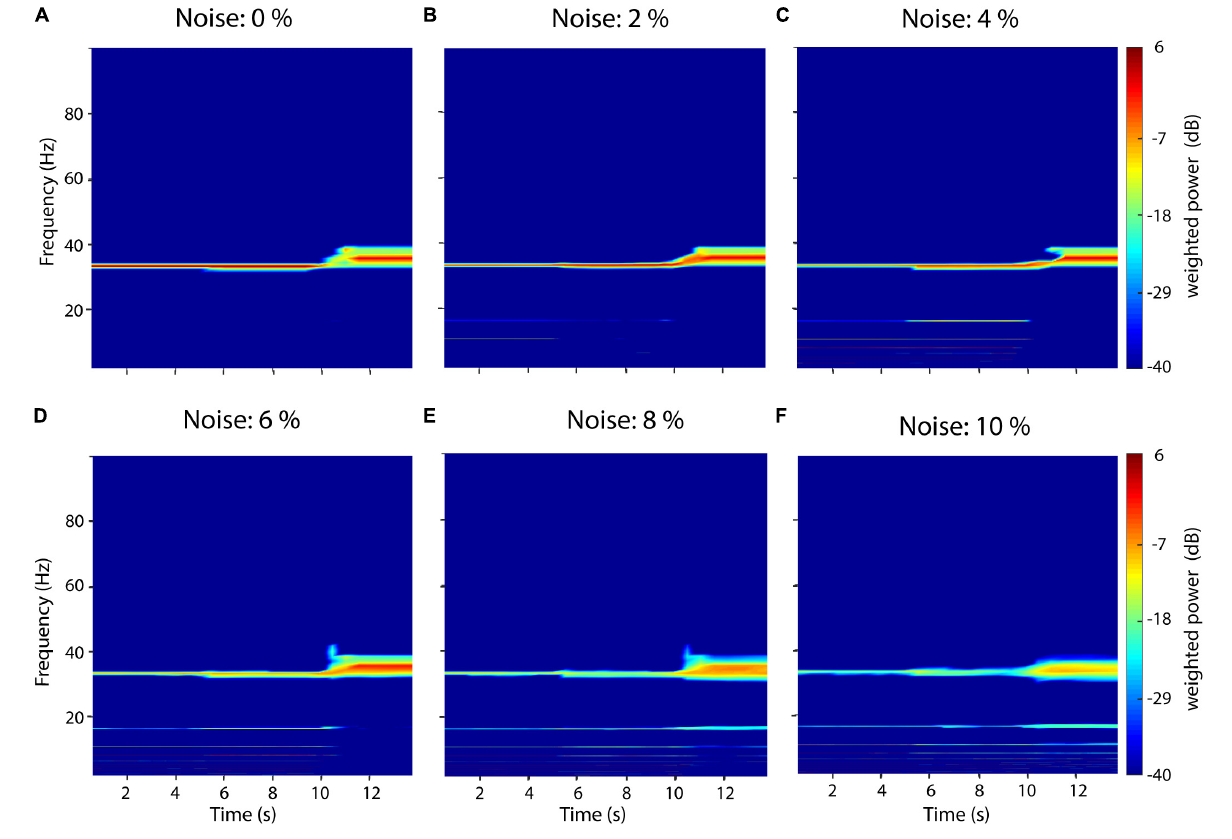
FIGURE 6 | Influence of white noise on recurrence amplitude estimation. Increasing white noise levels between 0 and 10% of the raw signal’s amplitude was added to a compound signal composed of three waveform shapes: 33-Hz sinusoid (0–5 s), a 33 Hz sawtooth wave (5–10 s), and a 33 Hz rectangle wave (10–15 s). (A) 0% white noise. (B) 2% white noise. (C) 4% white noise. (D) 6% white noise. (E) 8% white noise. (F) 10% white noise. Subharmonics appear with increasing noise